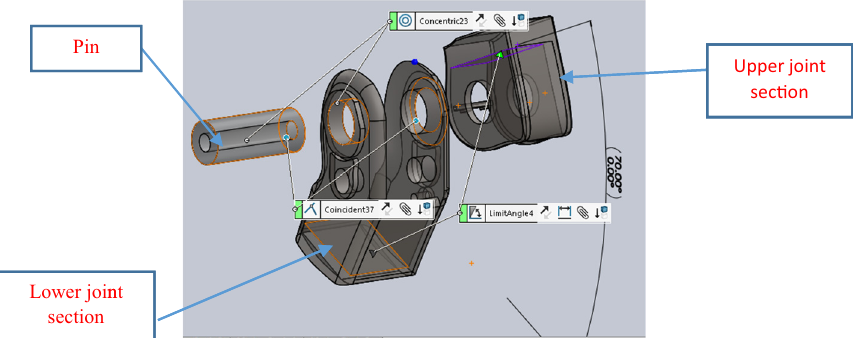
Figure 7: Knee joint single